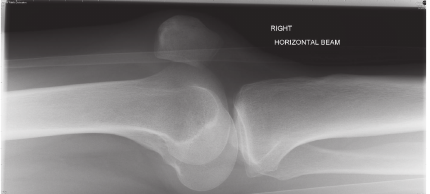
Figure 4: Lateral radiograph of the knee. The knee is held in extension and the patella is rotated 90